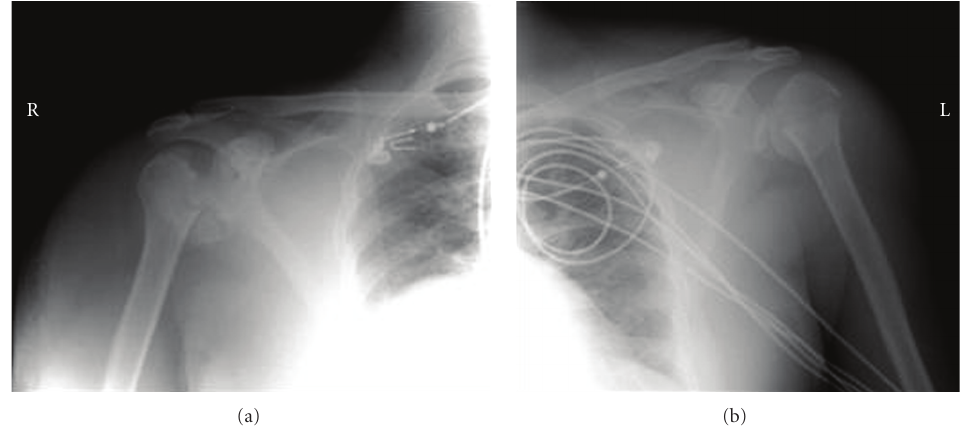
Figure 2: X. ray of both shoulders revealing dislocations.